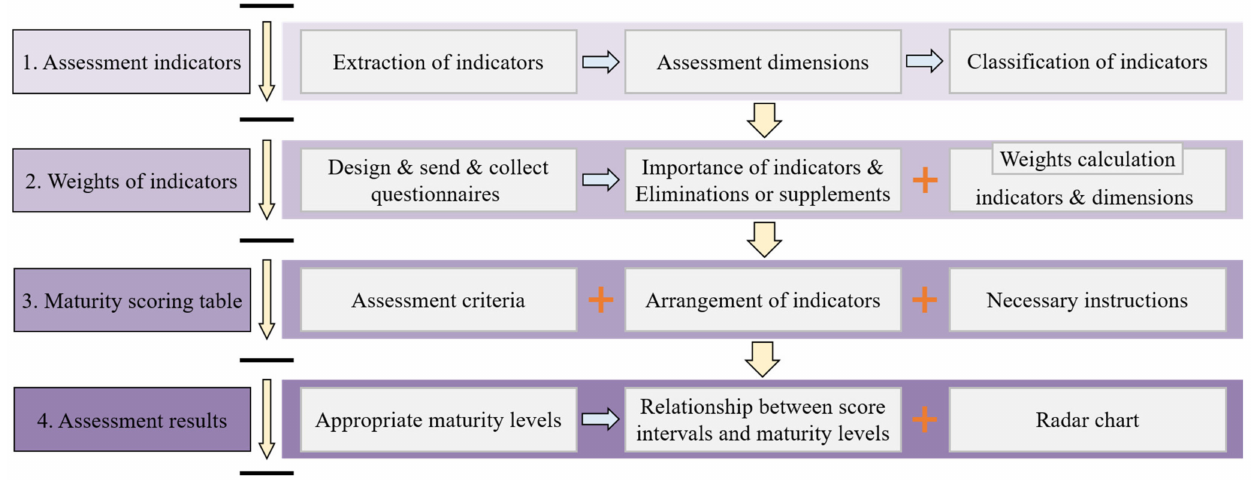
Figure 1. The construction process of the assessment